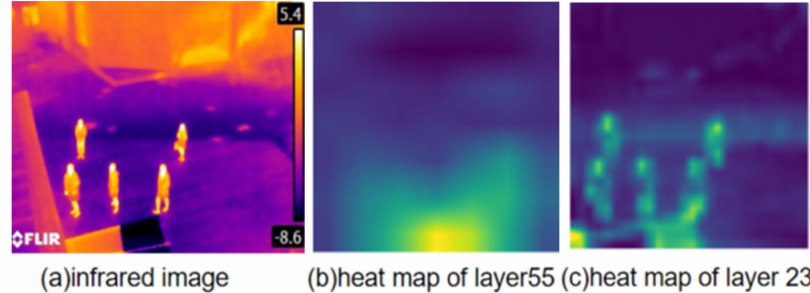
the area beyond the pedestrian in the Figure is the background